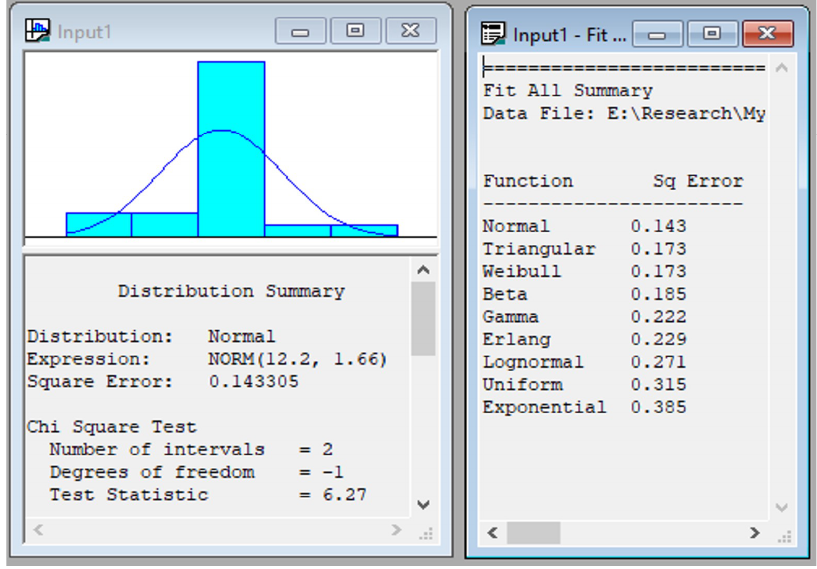
FIG. 6. DISTRIBUTION OF SERVED PATIENTS BY DOCTOR3